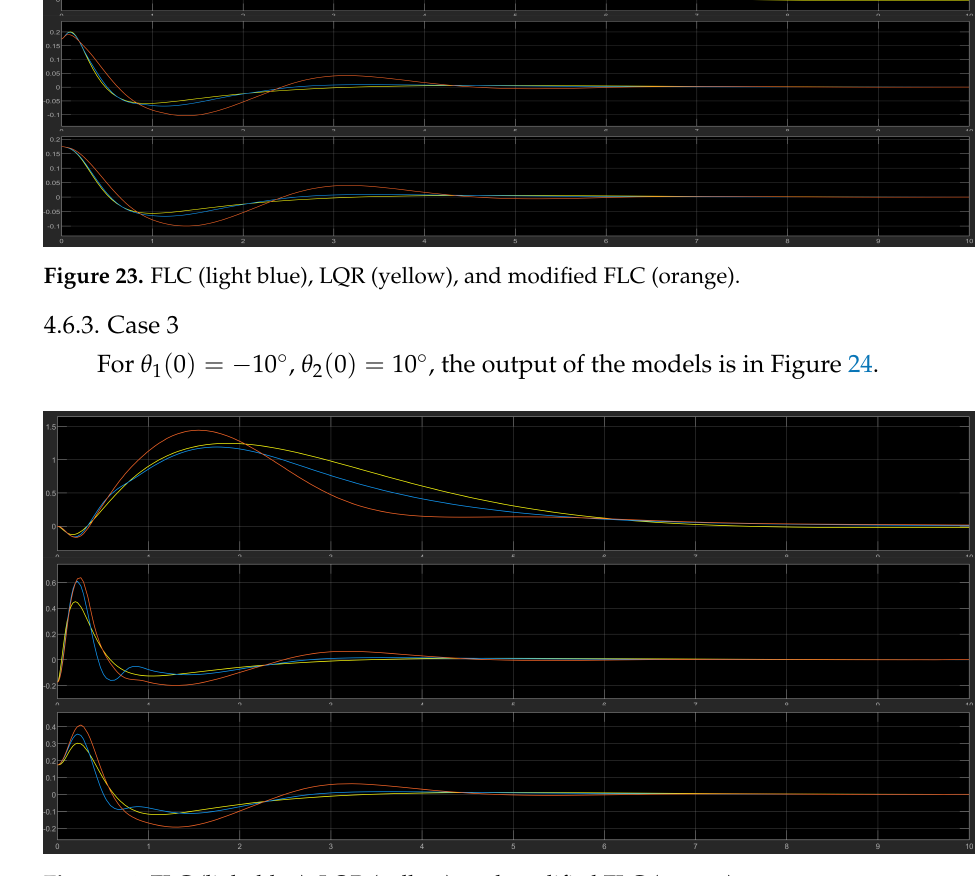
Figure 24. FLC (light blue), LQR (yellow), and modified FLC (orange).